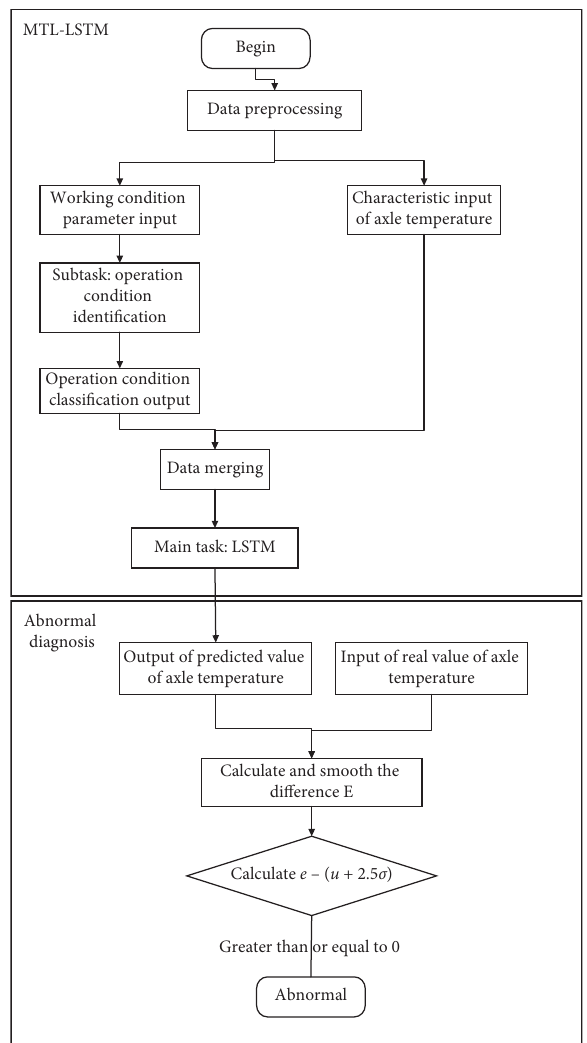
Figure 6: The flowchart of real-time diagnosis of bearing tem- perature